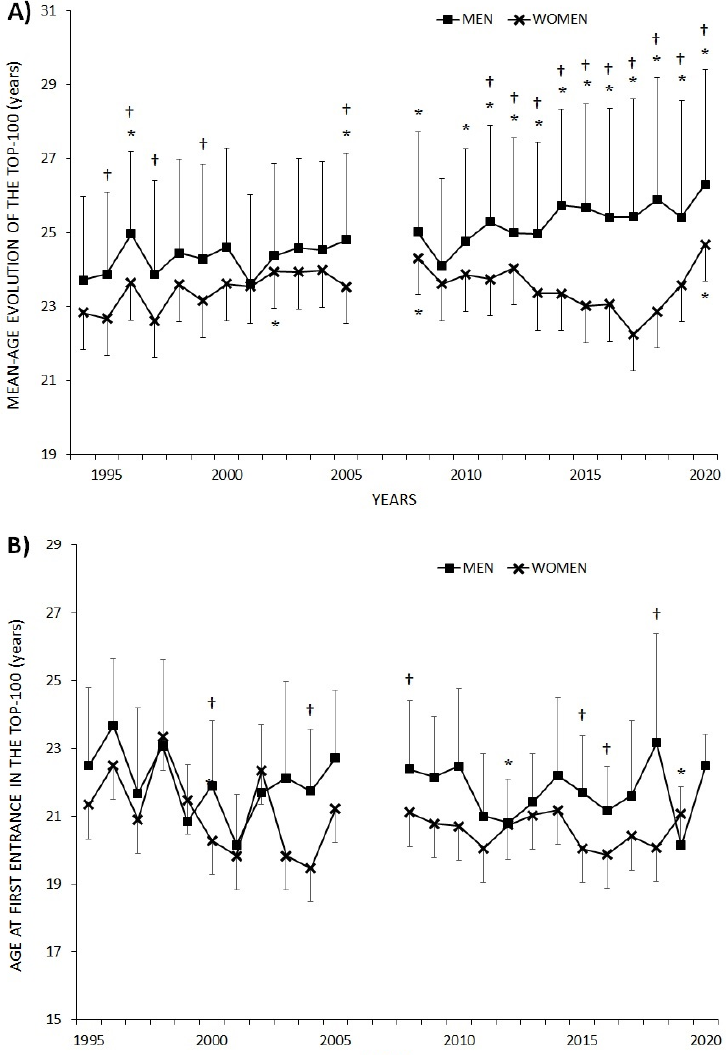
Figure 1. Evolution of average age in badminton players (both men and women) present in the World Ranking top 100 from 1994 to 2020 ( A ). Evolution of the average age of badminton players’ on their first entry in the World Ranking top 100 from 1995 to 2020 ( B ). * Significant differences in regard to the first record of the series in 1994 ( p < 0.05); † Differences between men and women in paired data ( p < 0.05).